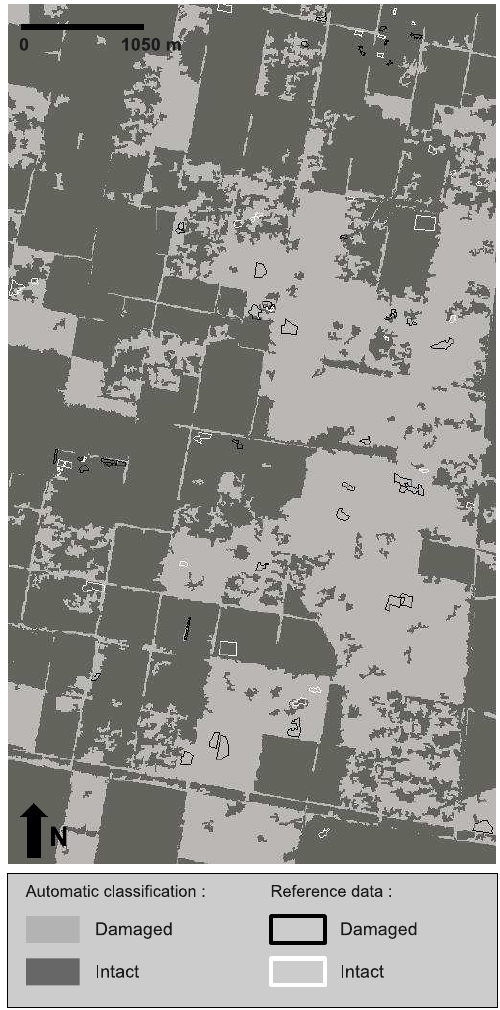
Figure 8: Binary map of wind storm damaged